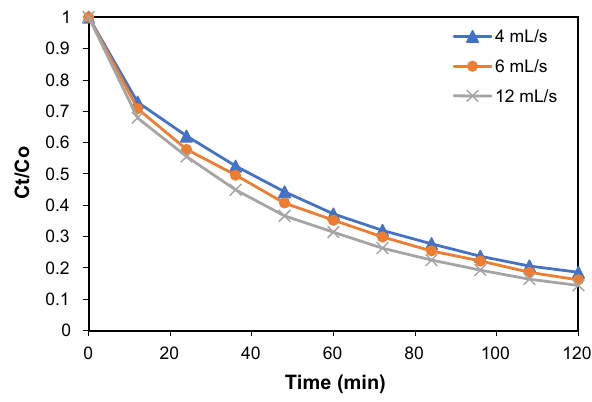
Fig. 7 Influence of flow rate on RhB removal ( C